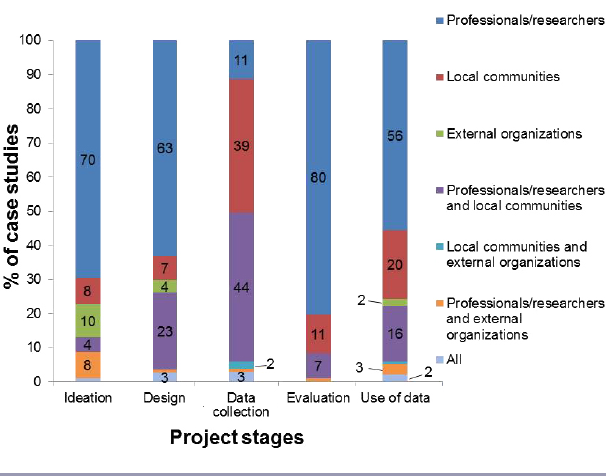
Fig. 2 . Actors’ participation in different project stages (n = 146